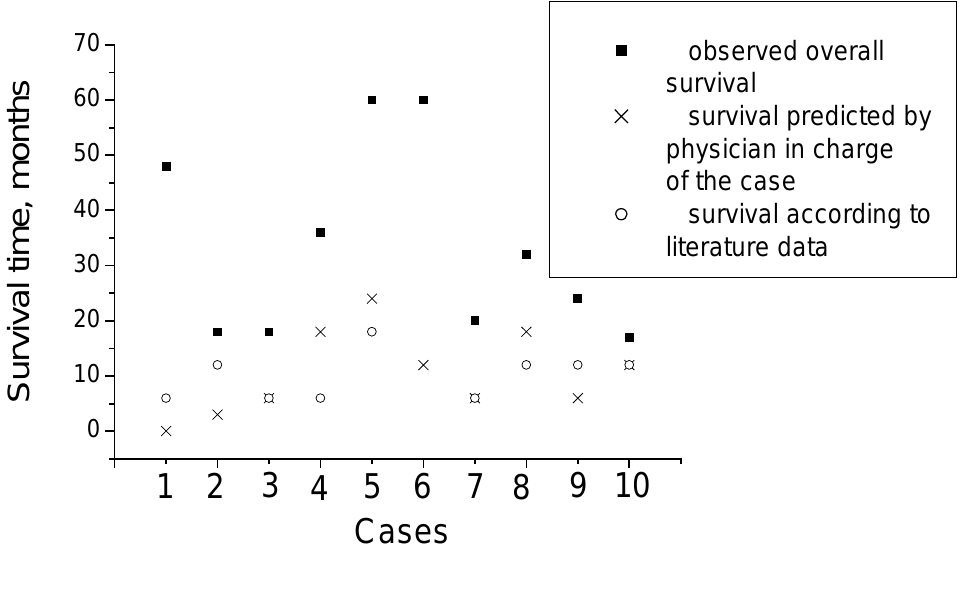
FIGURE 3. Survival period for patients that were under study and its comparison with predicted